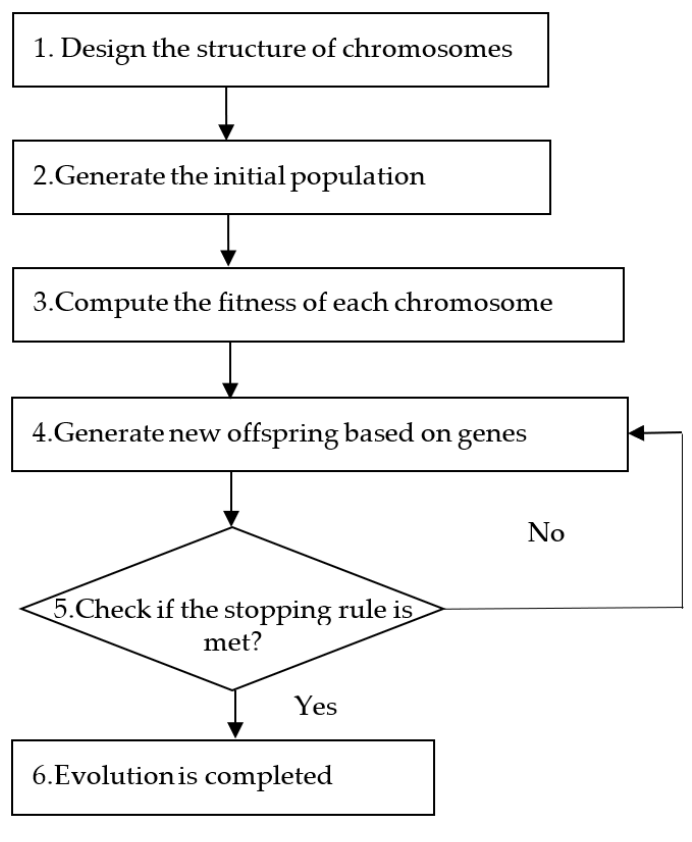
Figure 2. GA framework of the system.